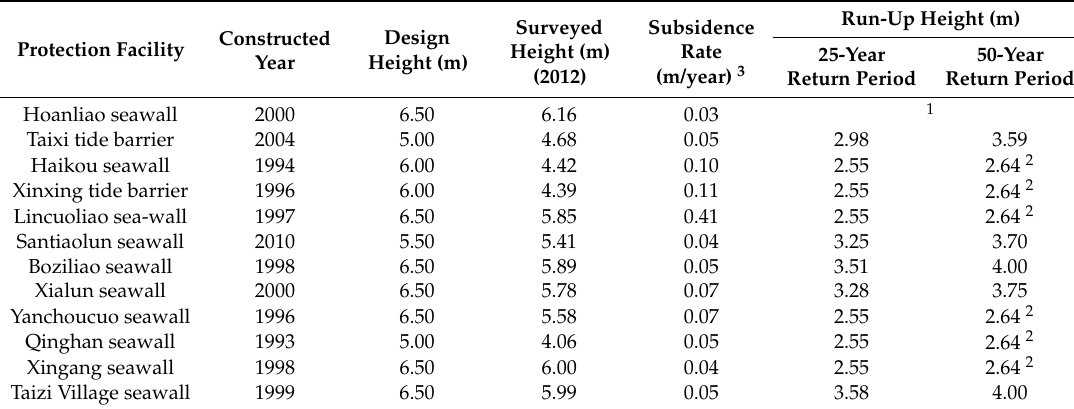
Table 5. Assessment of coastal defenses in Yunlin